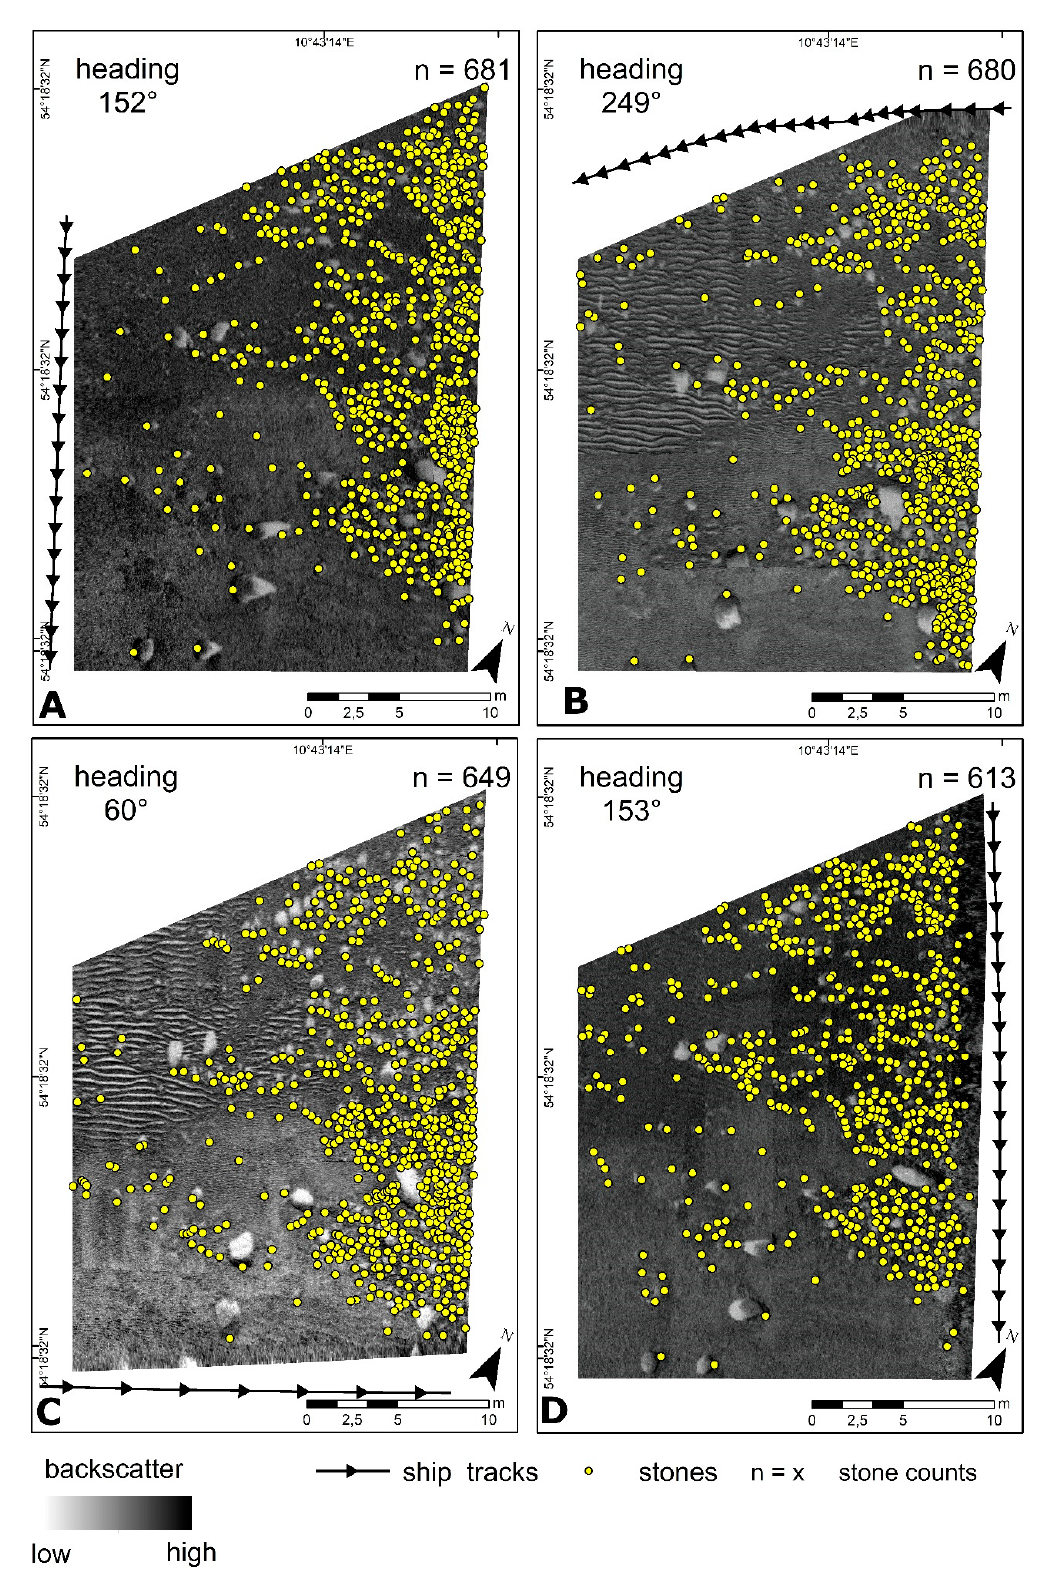
Figure 6. High-resolution SSS images of the study area. Dots represent detected boulders. The images A – D are generated with different headings and indicate different numbers of boulders.